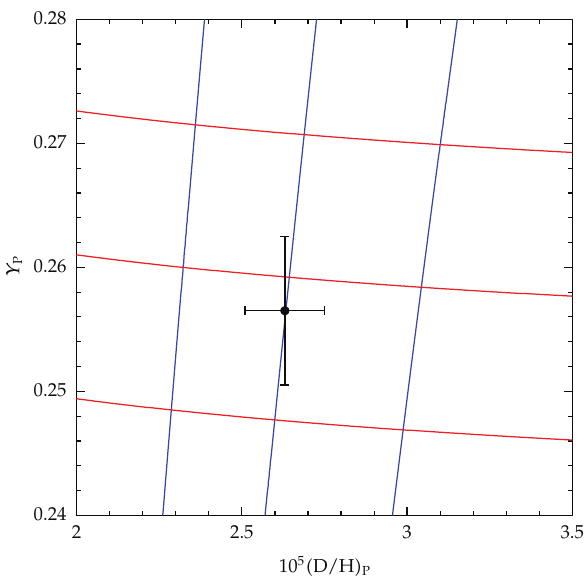
Figure 5: Contours of constant values of ξ (cid:3) red (cid:4) and η 10 (cid:3) blue (cid:4) in the Y P - y DP plane. From bottom to top the red curves correspond to Δ N ν (cid:7) 0 , − 0 . 05 , − 0 . 10. From left to right the blue curves correspond to η 10 (cid:7) 6 . 5 , 6 . 0 , 5 . 5. Also shown (cid:3) filled circle and error bars (cid:4) are the adopted primordial abundances of D and 4 He and their 1 σ uncertainties.